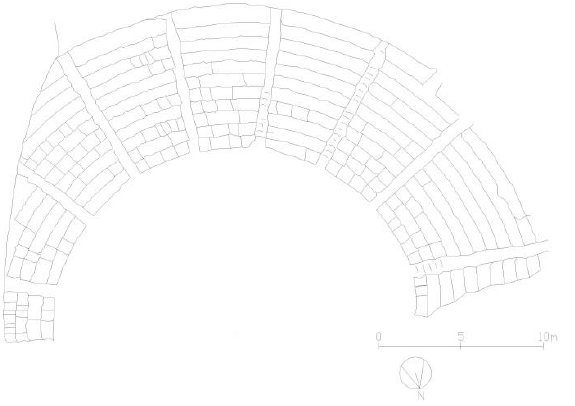
Figure 7 - Palazzolo Acreide, raw draw of the theatre